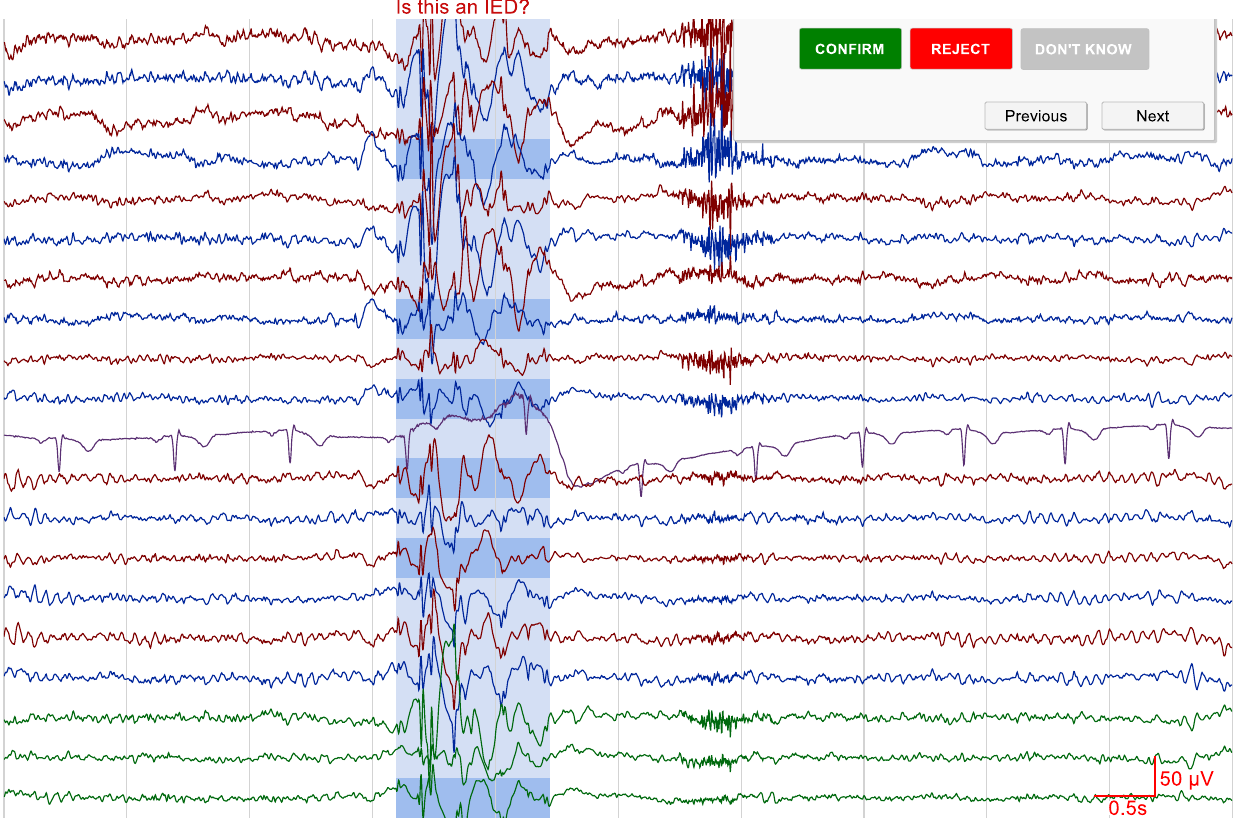
Figure 4. A screenshot showing how the review process works. For each iteration, the reviewer is presented with 10 nominations, one at a time, and is given the opportunity to either confirm, reject, or ignore each event as inter-ictal epileptiform activity (see top right panel). After the ten nominations have been graded, the user can choose to either stop with the review or to review another ten events. Nomination certainties are updated between